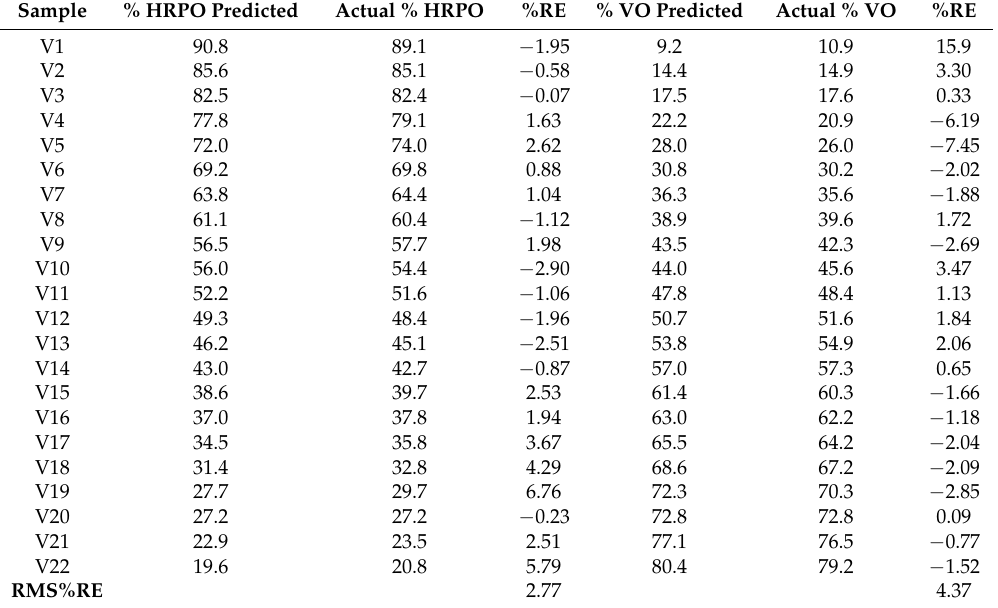
RE—relative error.